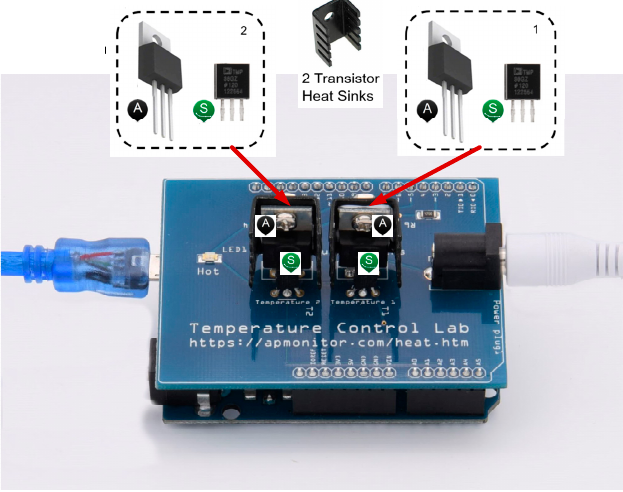
Figure 4. TCLab with power and USB connections. Actuators and sensors outlined with letters A and S, respectively.